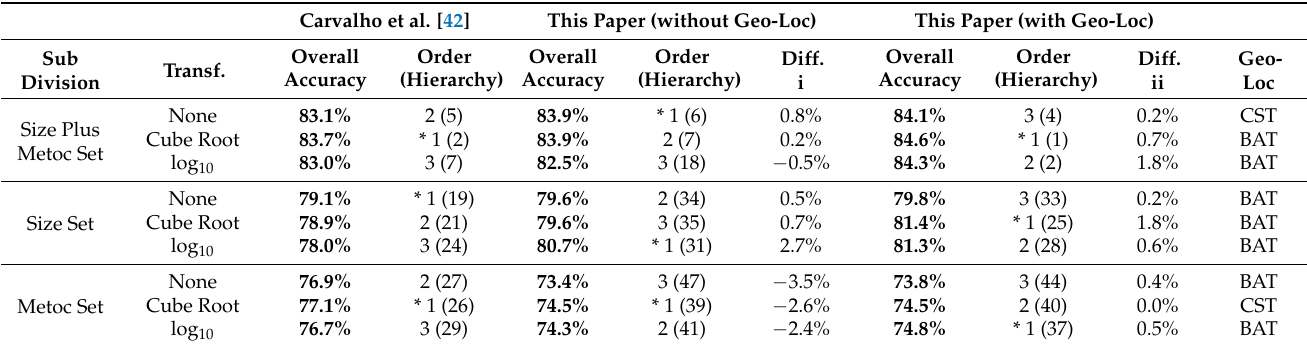
Table 5. Classification accuracy comparisons between our results (see the # symbol in Figure 3 and Table 3A,B) and those in Carvalho et al. [42]—see their Table 7. Attribute-type subdivision (Section 3.1.2): size information plus Meteorological- Oceanographic (metoc) variables, “Size Set”, and “Metoc Set”. In both studies, variables have been subjected to the same data transformation (Transf.). Herein, combinations were analyzed with or without at least one geo-location (geo-loc) parameter: bathymetry (BAT) or distance to coastline (CST). Overall accuracies are shown in bold font. A pair of differences in percentages (Diff.) are reported: (i) this study compared to Carvalho et al. [42]; and (ii) present study: with minus without geo-loc. A local order is provided per subdivision. The hierarchy (shown in parentheses) has been taken from Table 3A,B and Table 7 in Carvalho et al. [42]. * indicates the best accuracy within subdivisions. See also Section 4.2.4. Carvalho et al. [42] This Paper (without Geo-Loc) This Paper (with Geo-Loc)